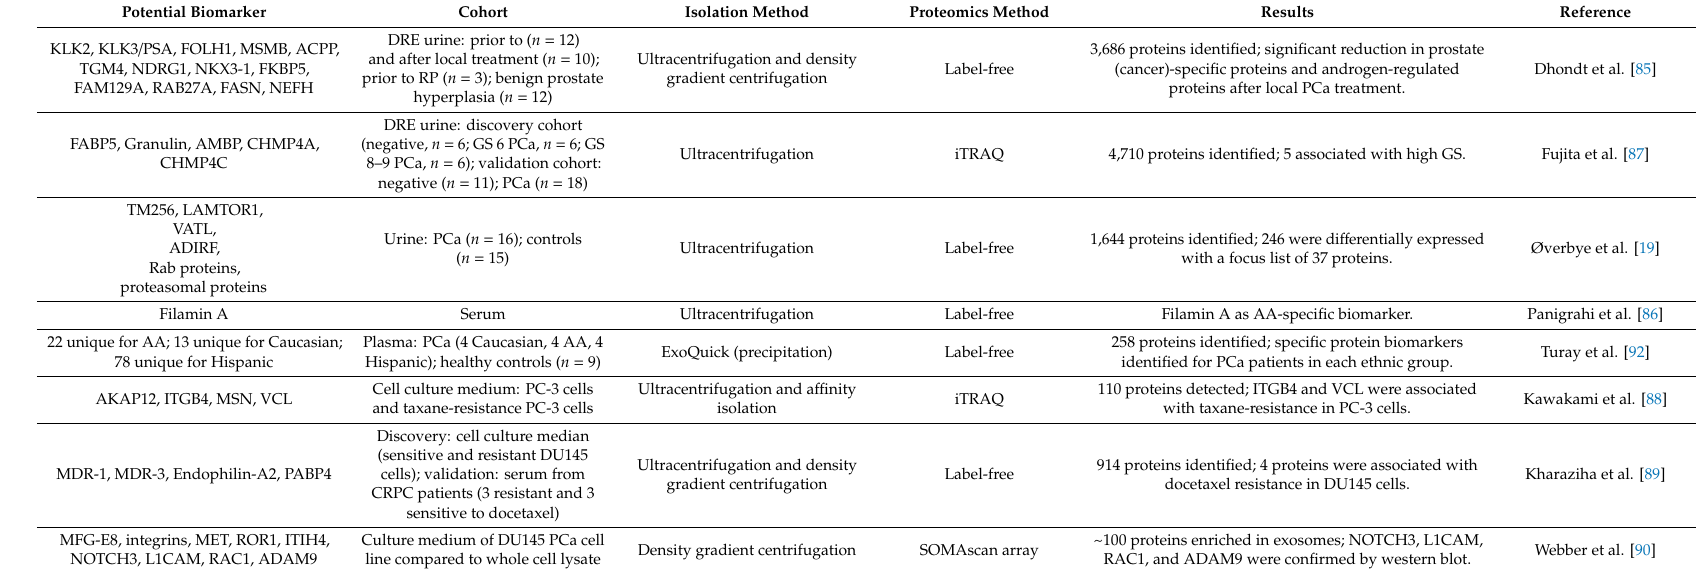
Table 2. Proteomic studies for exosome biomarker discovery of prostate